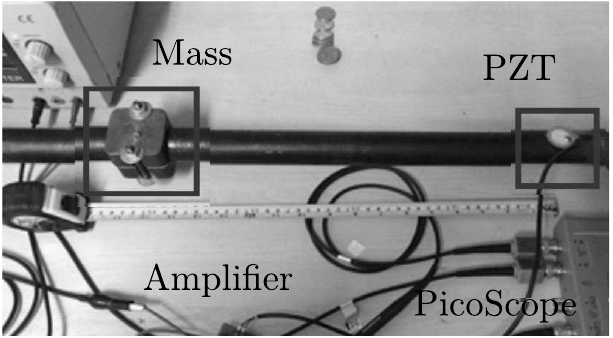
Figure 12. Mass displacement experiment mockup.